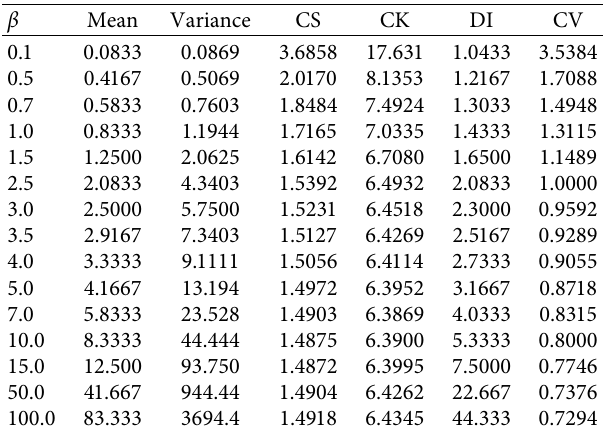
Table 2: VaR and TVaR for the DPB distribution. Table 1: Some numerical values of mean, variance, CS, CK, DI, and